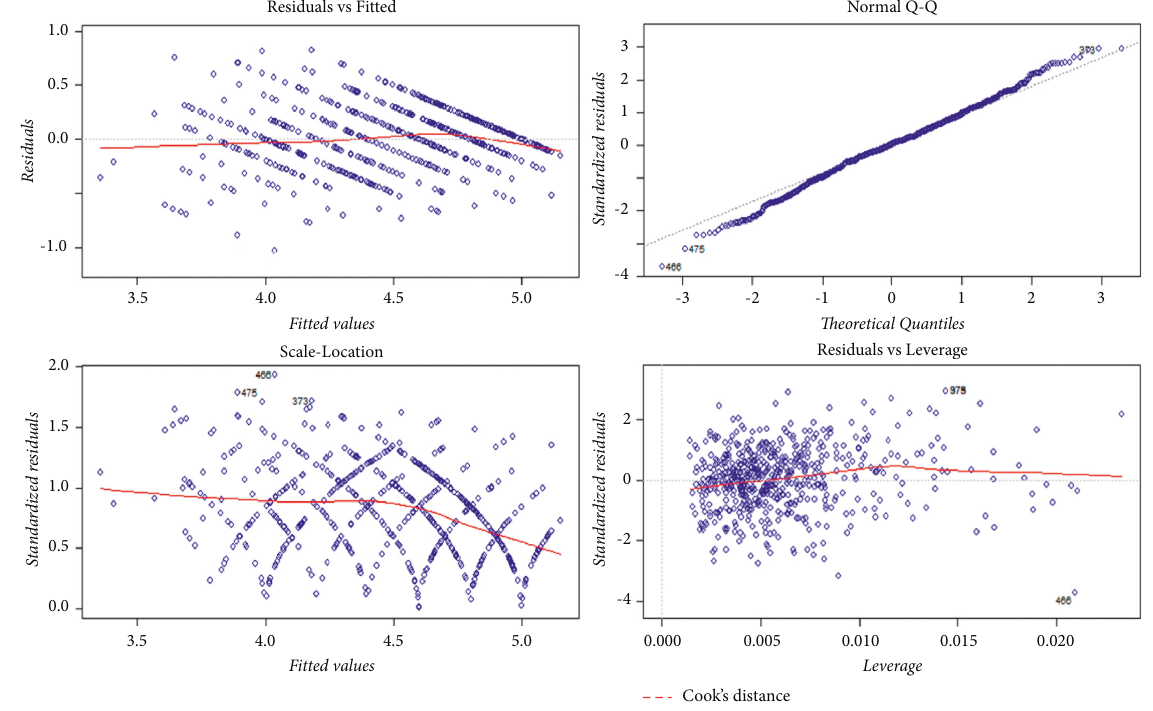
Figure 3: Assumptions for OLS